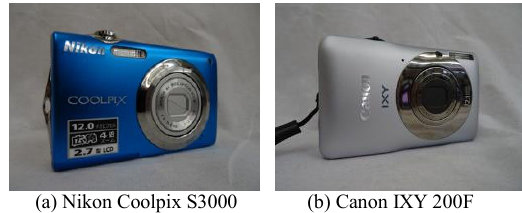
Table 1. Specifications of cameras